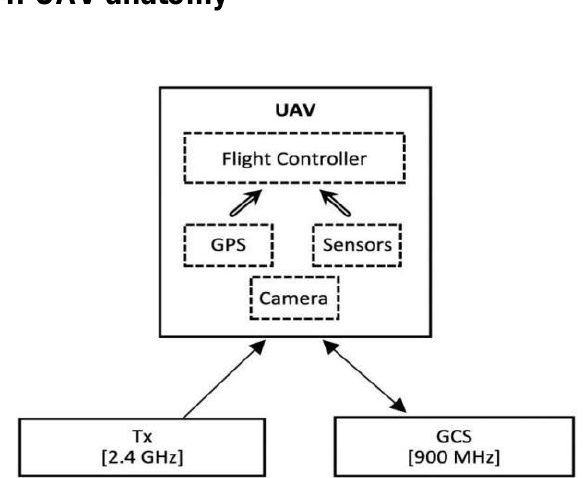
Fig.1. Simplified UAV System